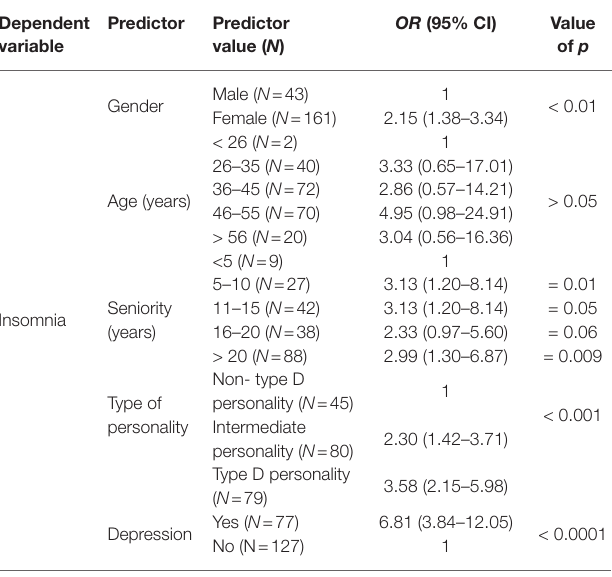
TABLE 5 | Factors determining the occurrence of insomnia in the group of surveyed